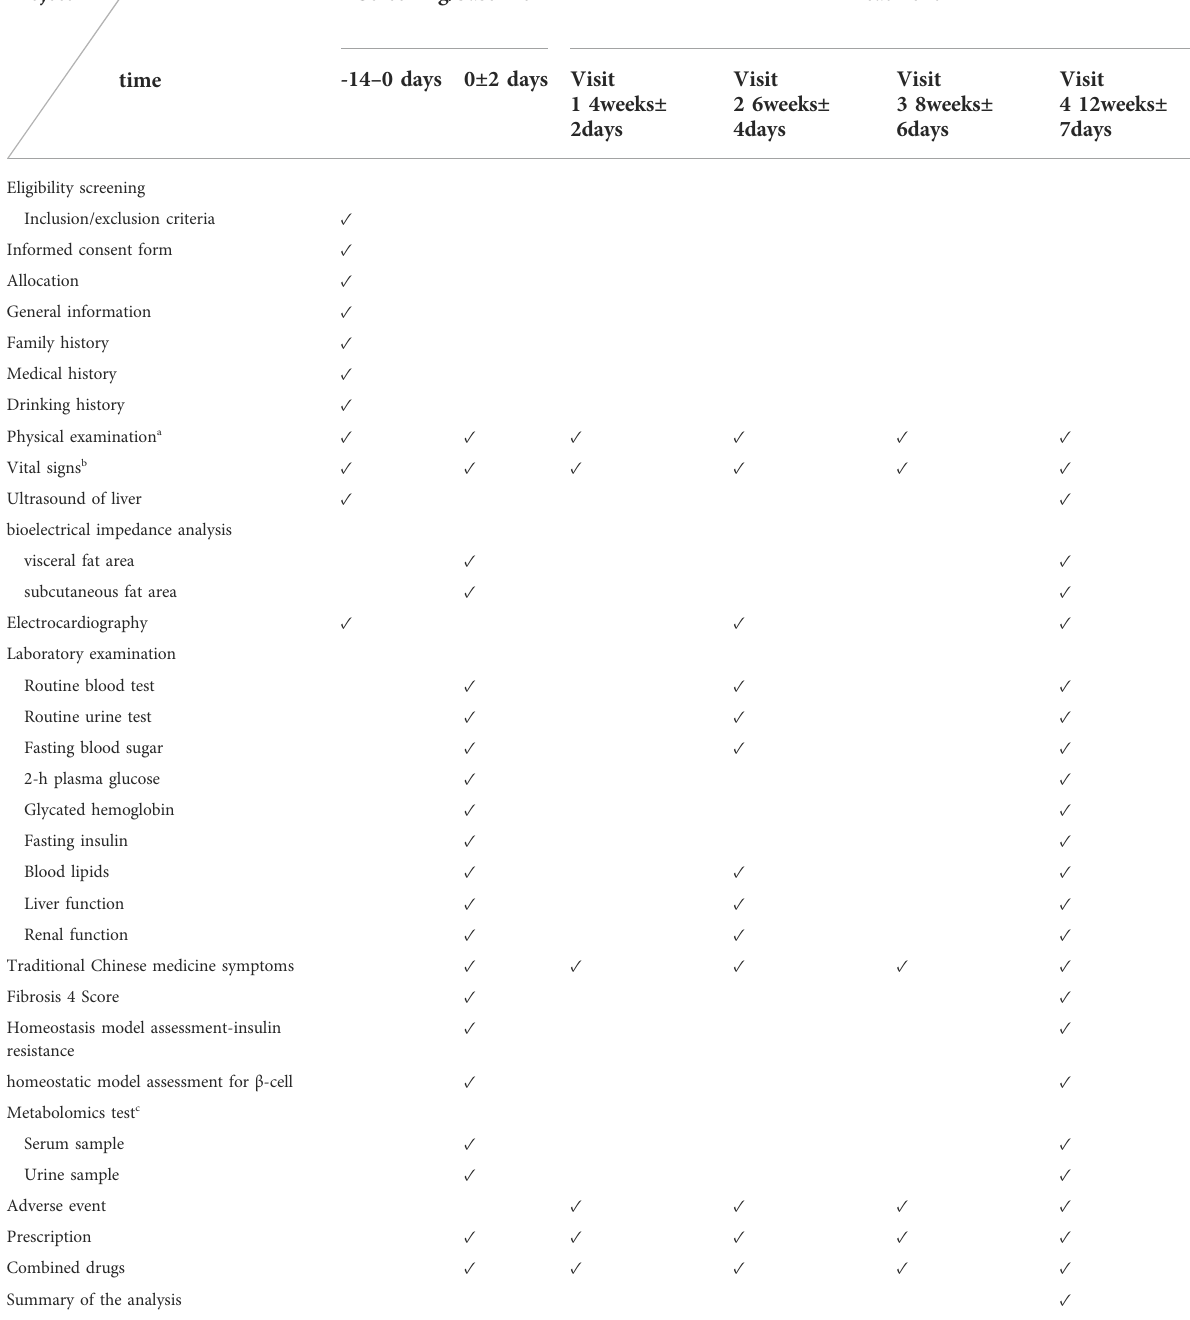
TABLE 1 Schedule of the clinical